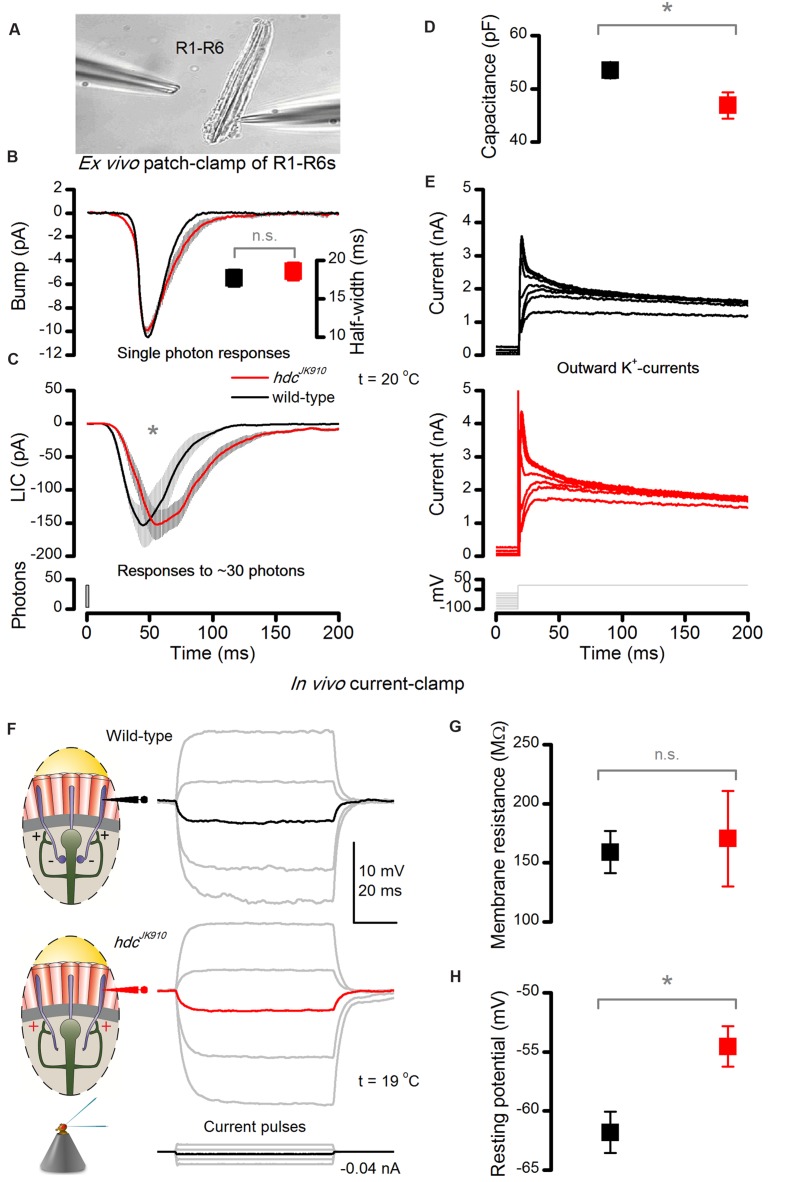
hdcJK910 photoreceptors’ macroscopic light-induced currents (LIC) peak and decay slower ex vivo and their in vivo dark resting potentials are higher than the wild-type.
(A) LICs and voltage-gated K+-currents were patch-clamp recorded from hdcJK910 and wild-type R1–R6 photoreceptors in ommatidia, dissociated from freshly eclosed flies. The image is adapted from (Abou Tayoun et al., 2011). (B) Characteristic hdcJK910 and wild-type single photon responses and their half-widths (insert). Bumps have a similar time course and mean sizes (bumphdc = 13.9 ± 0.8 pA, bumpwild-type = 16.2 ± 1.4 pA; p = 0.158, two-tailed t-test, nhdc = 8, nwild-type = 5). Quantum efficiency was not significantly different (QEhdc = 0.62 ± 0.04, QEwild-type = 0.64 ± 0.02; p = 0.805, two-tailed t-test, nhdc = 8, nwild-type = 5). (C) Macroscopic hdcJK910 LICs showed slower than wild-type dynamics. (time-to-peakhdc = 60.4 ± 9.7 ms, time-to-peakwild-type = 46.1 ± 8.1 ms; p = 0.008, one-tailed t-test, nhdc = 5, nwild-type = 8). (D) Interestingly, the hdcJK910 membrane capacitance was lower than the wild-type (Chdc = 46.9 ± 5.5 pF, Cwild-type = 53.5 ± 4.2 pF; p = 0.016, one-tailed t-test, nhdc = 5, nwild-type = 8). Mean leak currents did not differ significantly (leakhdc = -8.2 ± 10.2 pA, leakwild-type = -10.1 ± 9.0 pA; p = 0.720, two-tailed t-test, nhdc = 5, nwild-type = 8). (E) Voltage-gated K+-currents of hdcJK910 and wild-type R1–R6 photoreceptors show similar amplitudes and dynamics; these representative traces are well within the natural variability. (F) Voltage response of dark-adapted wild-type and hdcJK910 photoreceptors, recorded in vivo to intracellularly injected current pulses. (G) Membrane resistance of hdcJK910 photoreceptors are wild-type-like (mRhdc = 170.5 ± 40.4 MΩ, mRwild-type = 159 ± 17.8 MΩ; p = 0.807, two-tailed t-test, nhdc = 4, nwild-type = 4). (H) In darkness, the resting potential of hdcJK910 photoreceptors is significantly higher than in the wild-type (Vhdc = -54.5 ± 1.7 mV, Vwild-type = -61.8 ± 1.74 mV; p = 0.011, one-tailed t-test, nhdc = 4, nwild-type = 5). (D–H) Mean ± SEM. All recordings performed at t = 19°C.